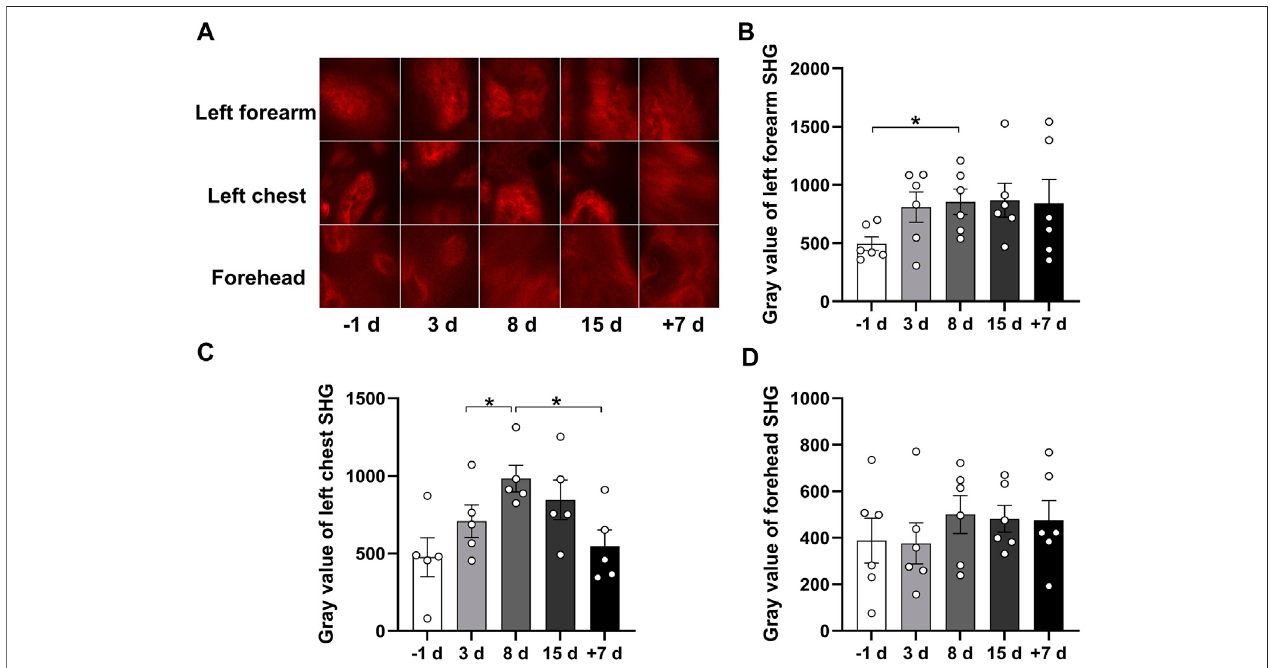
FIGURE4| QualitativecomparisonofskinSHGduring15 daysofhead-downbedrest. (A) TypicalimagesofSHGintensityinthesubcutaneousbasalscelllayerin differentpartsoftheskinasafunctionoftimeinbed. (B – D) ChangesofSHGintensityintheskinbasalecelllayerofleftforearm,leftchest,andforeheadduring15 daysof head-down bed rest. Data represent mean ± SEM. Signi fi cant values are determined as * p < 0.05 (Tukey ’ s multiple comparisons paired test).